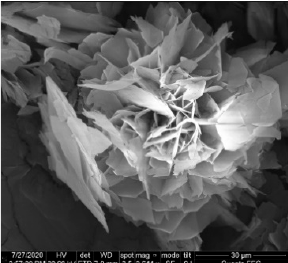
Figure 6. The 43 mM L-glu crystallized in a water–ethanol mixture.